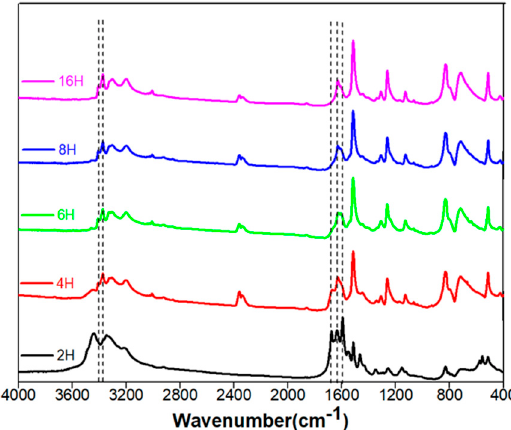
Figure 2. FT-IR spectra of U-PPD at 2, 4, 6, 8 and 16 h reaction time.